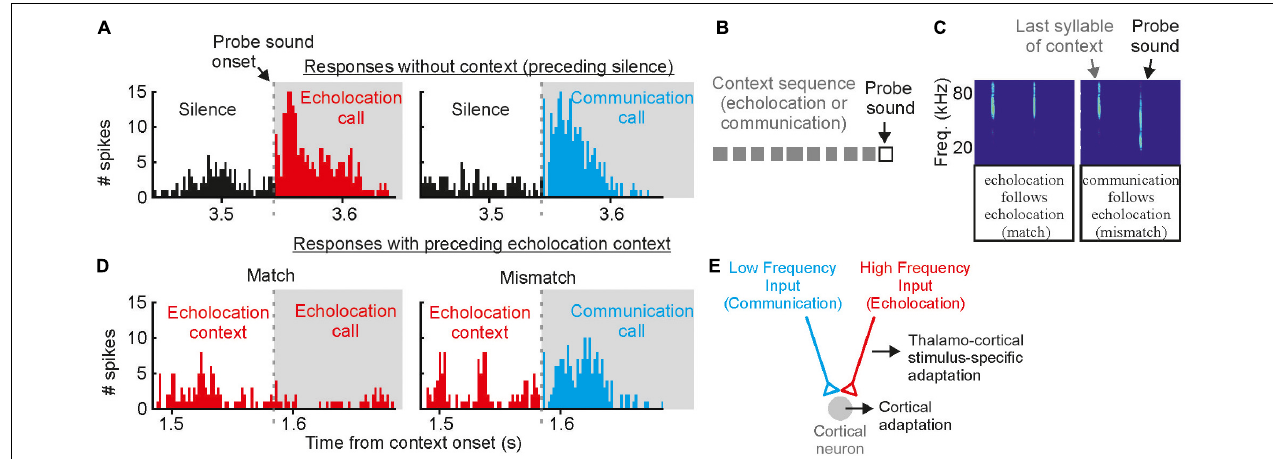
FIGURE 8 | Contextual modulation of auditory responses in the auditory cortex of awake bats. (A) Example cortical unit that responds equally well to echolocation and communication sounds preceded by silence. (B) Schematic representation of the stimulation paradigm in which context (gray squares) precede a probe sound. (C) Spectrograms depicting the last syllable of context and the following probe sound. Two cases are shown: (1) match (echolocation follows echolocation) and (2) mismatch (communication follows echolocation). (D) Responses of the same cortical unit as in (A) to the echolocation and communication probes preceded by an echolocation sequence. Although the response to the probe was suppressed in both cases, the suppression was less severe in the mismatch. (E) Circuit that best explains the results obtained in vivo and modeling experiments. Data from Lopez-Jury et al.